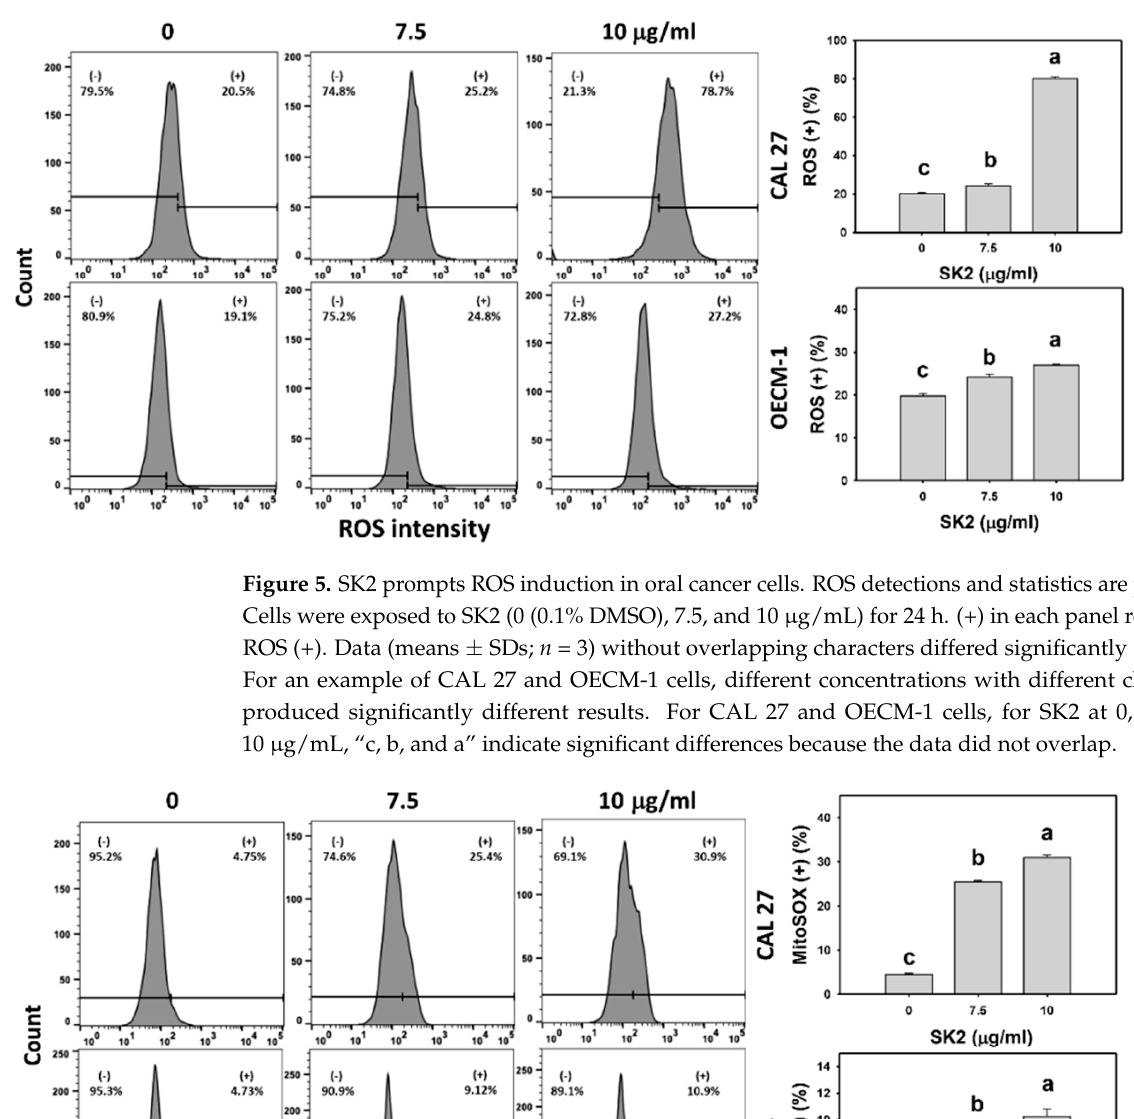
Figure 6. SK2 prompts MitoSOX induction in oral cancer cells. MitoSOX detections and statistics are provided. Cells were exposed to SK2 (0 (0.1% DMSO), 7.5, and 10 µg/mL) for 24 h. (+) in each panel represents MitoSOX (+). Data (means ± SDs; n = 3) without overlapping characters differed significantly ( p < 0.05). For an example of CAL 27 and OECM-1 cells, different concentrations with different characters produced significantly different results. For CAL 27 and OECM-1 cells, for SK2 at 0, 7.5, and 10 µg/mL, “c, b, and a” indicate significant differences because the data did not overlap.